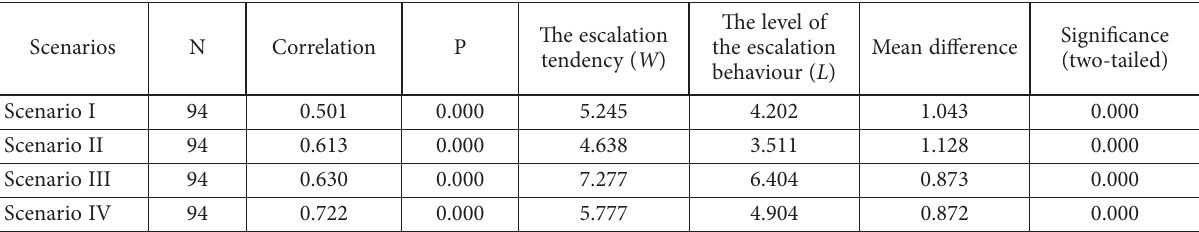
Table 6. The correlation and a t -test of investors’ escalation tendency and